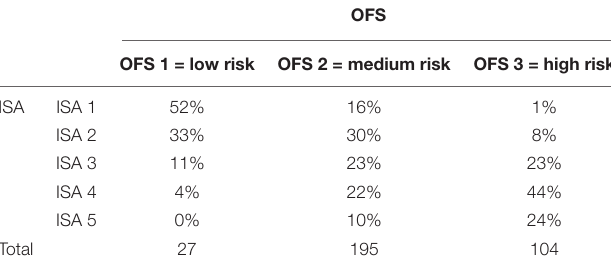
TABLE 5 | Operator Functional State contingency table for OFS and ISA.